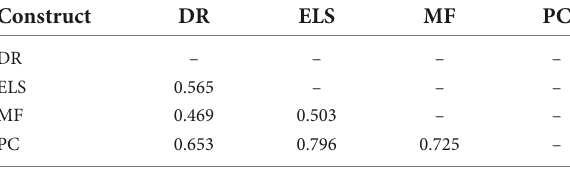
TABLE 3 Discriminant validity (HTMT).